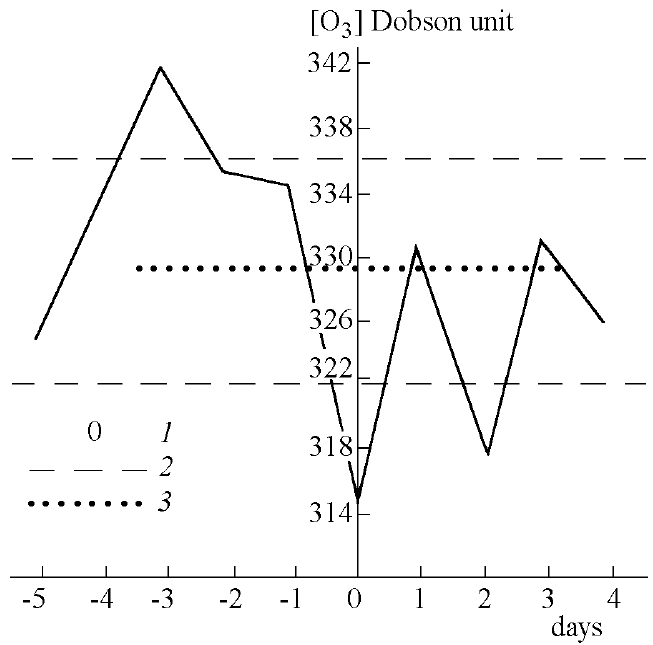
Figure 1. Ozone level changes associated with 88 strong earthquakes of magnitudes 4.5–7.2 in Central Asia from 1973 to 1985 (solid line) [59]. A Dobson unit is the column in Earth atmosphere equivalent to a 10 µm thick layer of O density of O 3 temperature and pressure. Dotted line: average O Dashed lines: 95% confidence